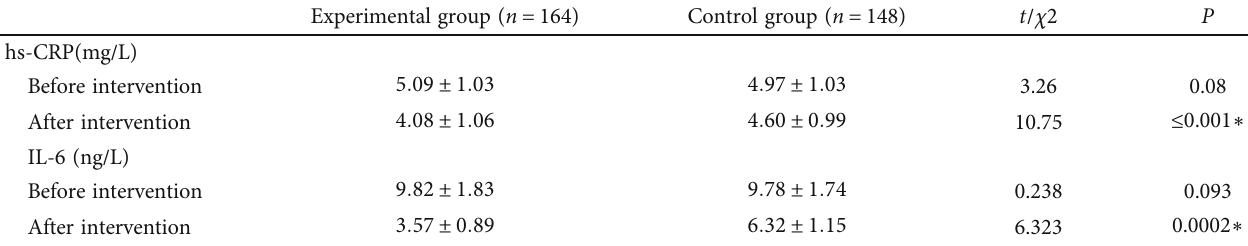
Table 3: Comparison of in fl ammatory indicators between the two groups before and after intervention ( (cid:1) x ± s ). Experimental group ( n = 164